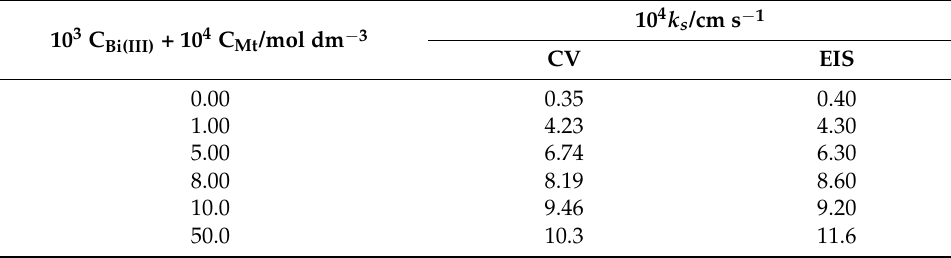
Table 2. The values of standard rate constants k s of 1 × 10 − 3 mol dm − 3 Bi(III) electroreduction in 1 mol dm − 3 chlorate(VII) and in the presence of methionine estimated with CV and